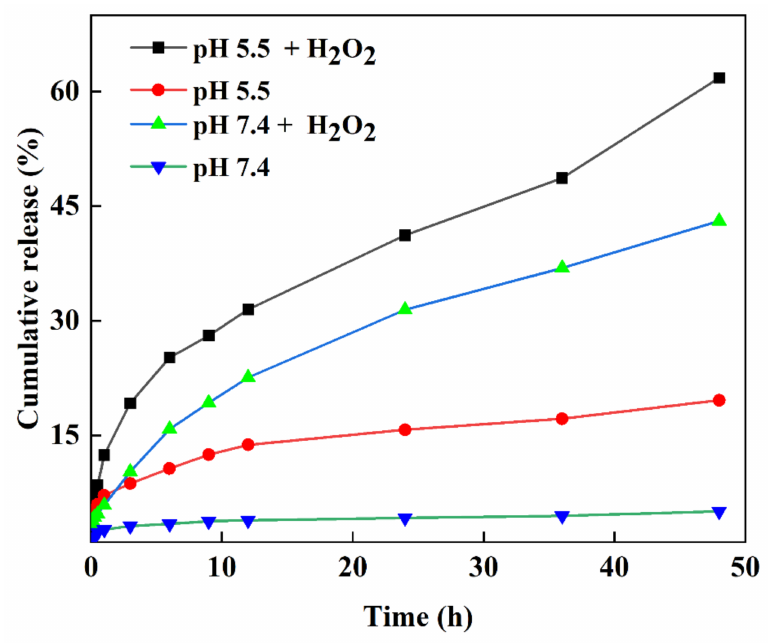
Figure 11. The drug release curves from the MXene − TK − DOX@PDA nanoparticles in different media.